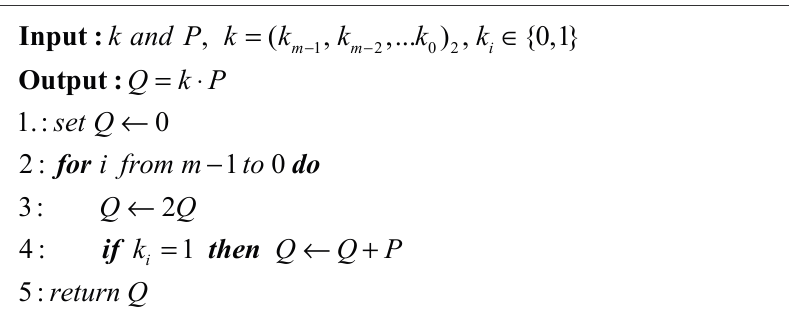
Algorithm 1. Binary Method for scalar point